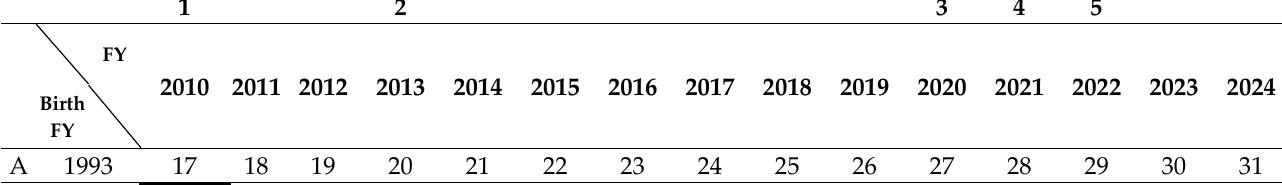
Table 1. The events in Japan regarding the HPV vaccine and its target population.